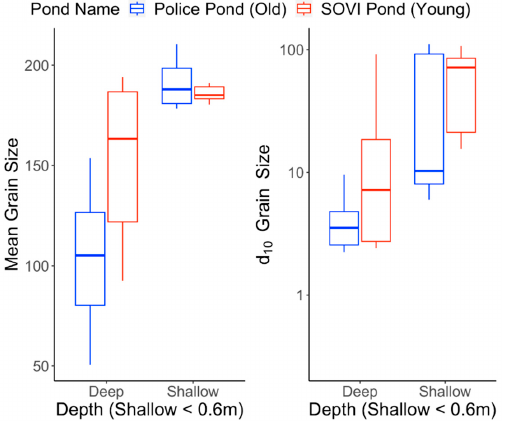
Figure 9. Grain size comparison between the Police Pond constructed in 1996 and the SOVI Pond constructed in 2017.